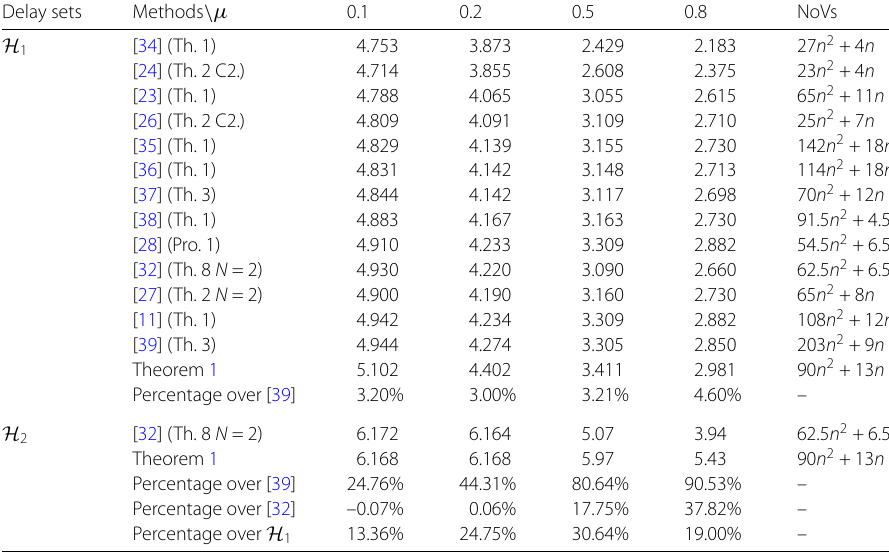
Table 3 MAUB s h for different μ (Example 3) Delay